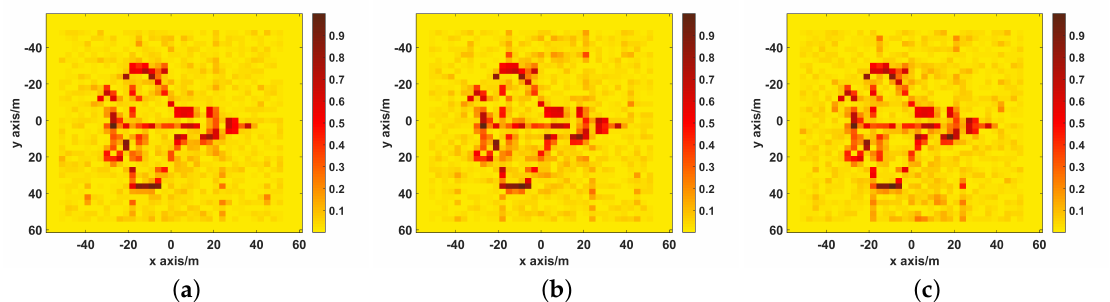
Figure 15. The imaging results of UPIM when only one rotation component exists. ( a ) Only yaw angle, the NMSE is 0.27; ( b ) Only pitch angle, the NMSE is 0.28; ( c ) Only roll angle, the NMSE is 0.28.